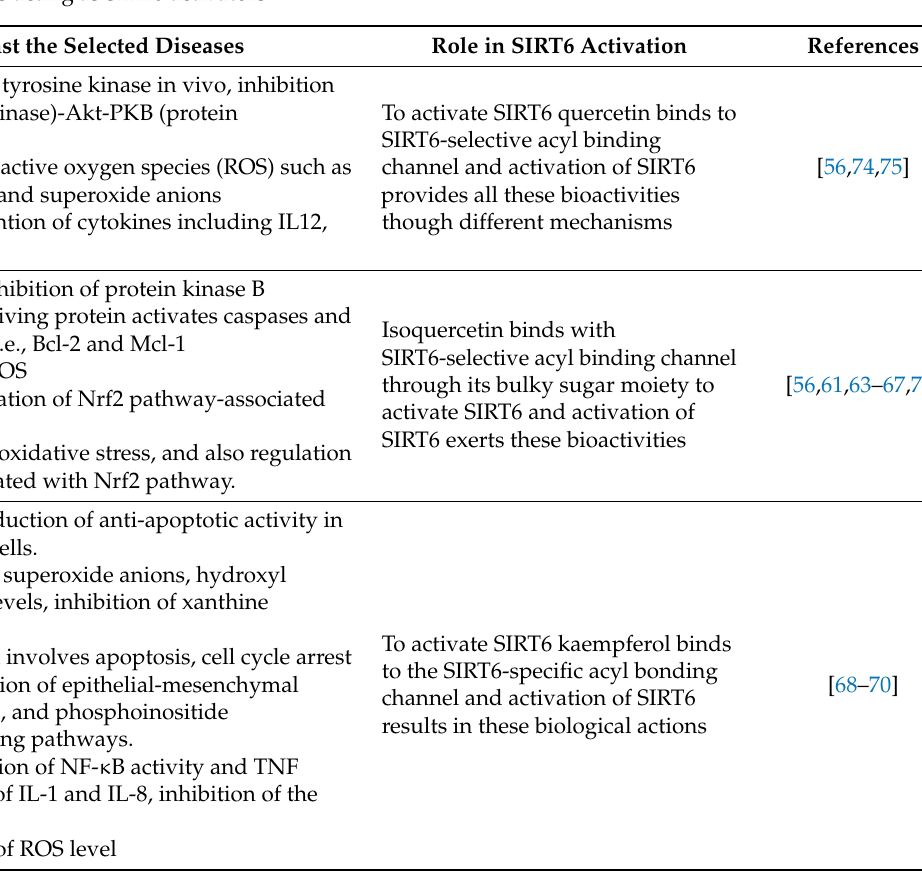
Table 2. Natural products acting as SIRT6